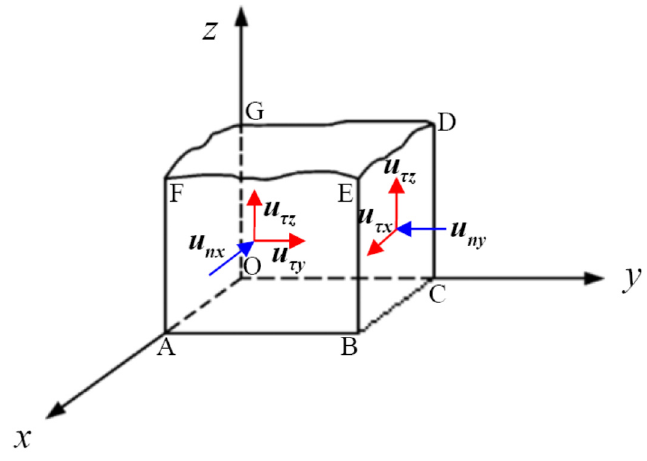
Figure 3. Sketch of displacements on boundaries ABEF and BCDE.